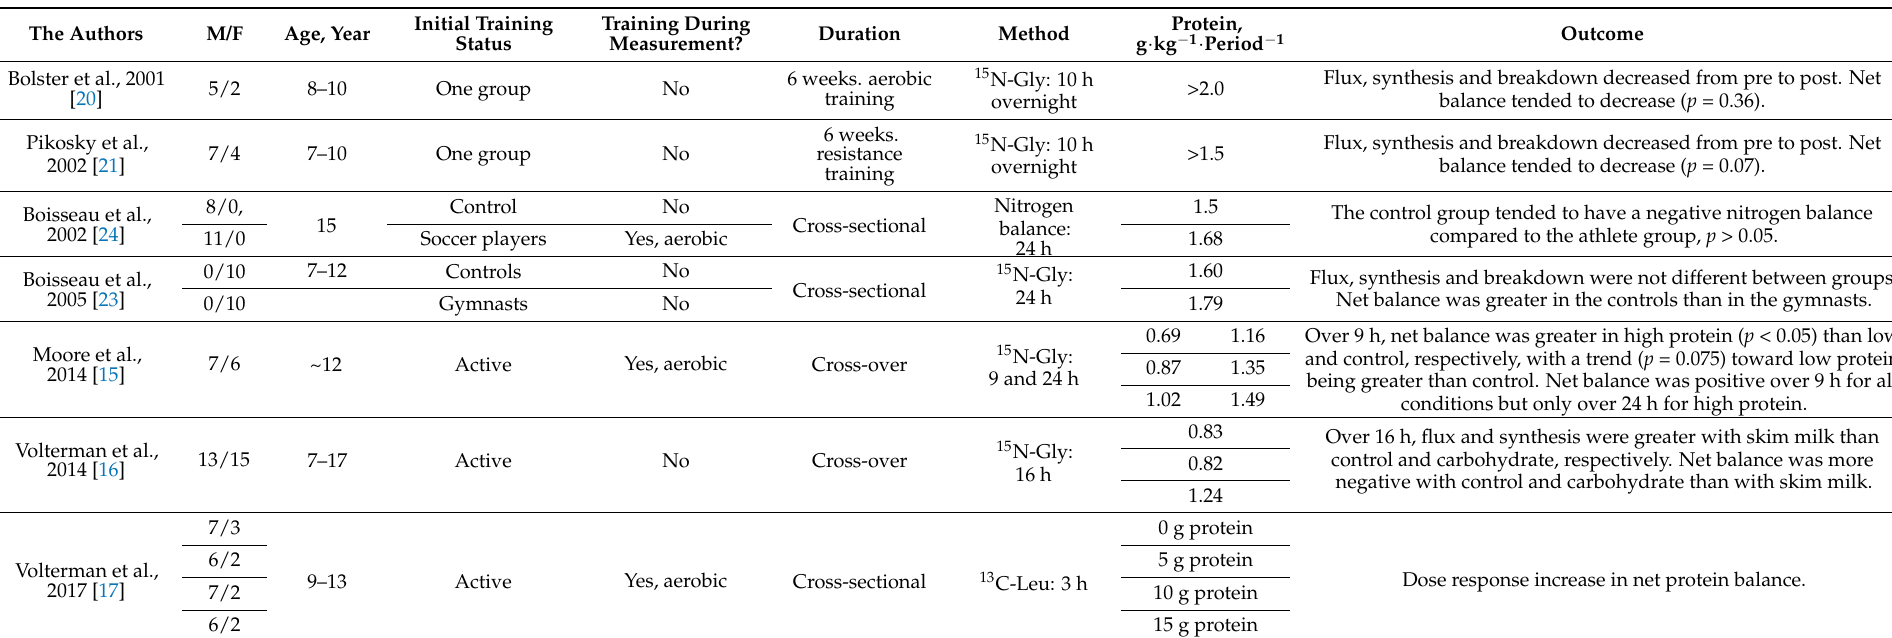
Table 2. Studies on protein intake, physical activity and whole-body protein turnover in